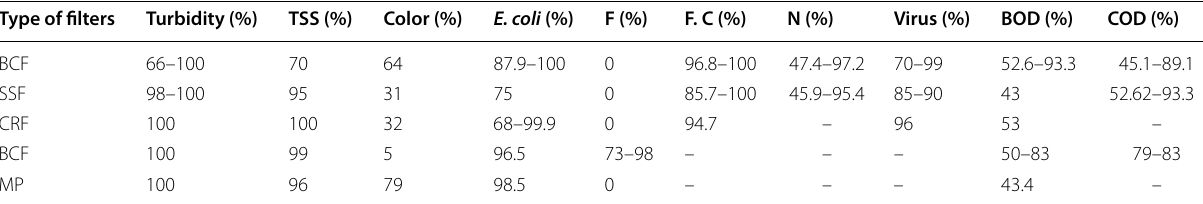
BSF, bio sand filter; SSF¸ slow sand filter, CRF, ceramic filter; BCF, bone char; MP, membrane purifiers; –, not reported